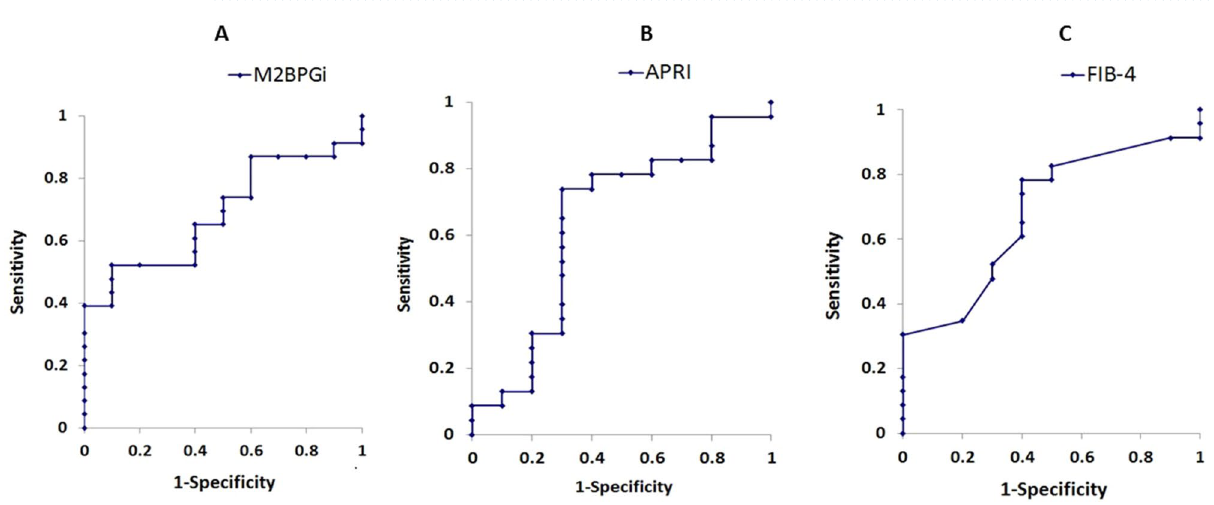
Figure 2. ROC curve analysis of M2BPGI ( A ), APRI ( B ) and FIB-4 ( C ) to discriminate stage F1 fibrosis from